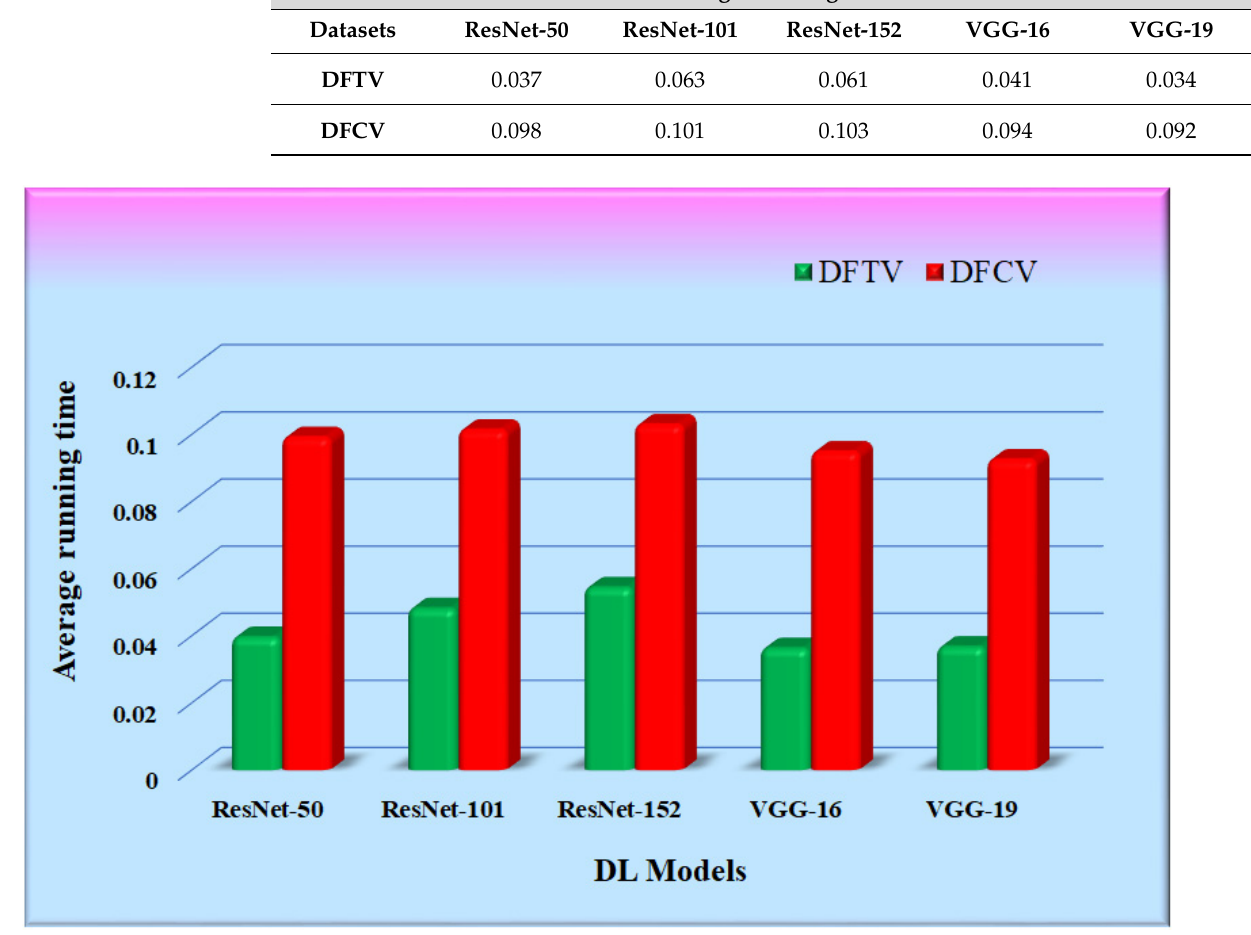
Figure 17. Graphs for average running time comparison.